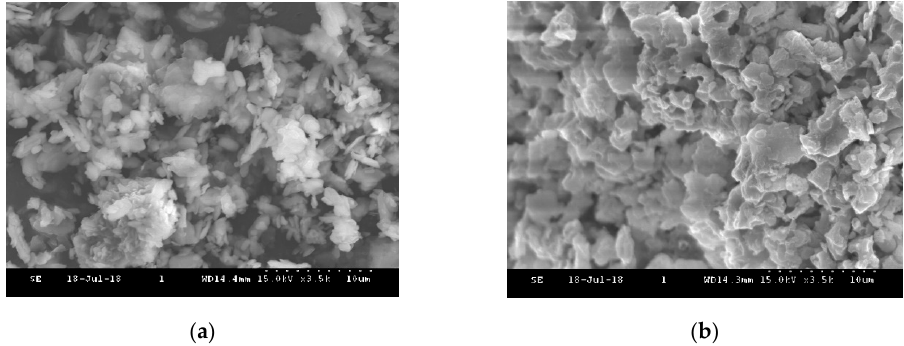
Figure 4. SEM images of the MV pigment: ( a ) Room temperature; ( b ) 410 ° C.